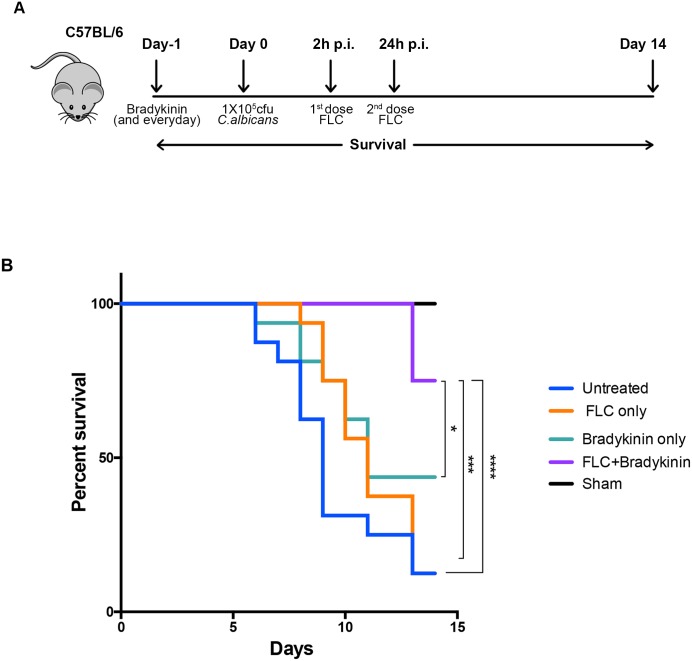
Combination of fluconazole and bradykinin increased survival of C. albicans infected mice.
(A) Experimental design for combinatorial fluconazole and bradykinin therapy strategy (B) WT mice (n = 16) were infected with C. albicans. Infected mice were treated with two doses of FLC only (5 mg/kg at 2 and 24 h p.i.), bradykinin only (300nmol/kg starting 1 day prior to infection and daily for 14 days) or a combination of FLC and bradykinin. Sham-infected mice (n = 3) were treated with FLC, bradykinin or both. Survival was assessed over 14 d. Data are combined from 3 independent experiments. p<0.05 (*), p>0.001 (***), p>0.0001 (****).